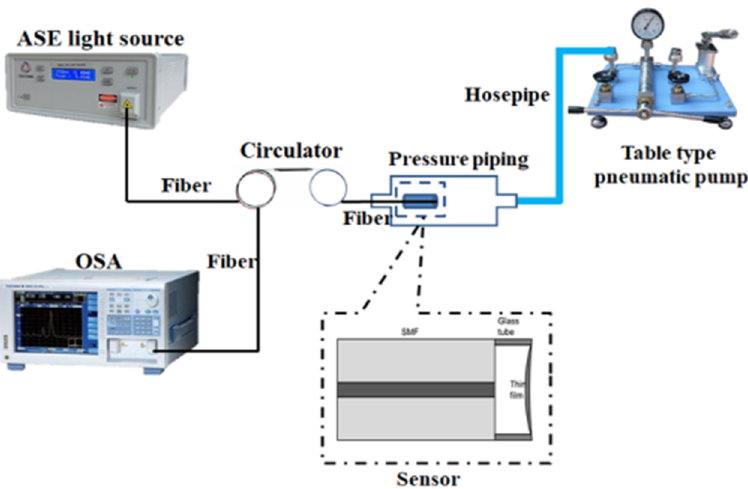
Figure 8. Schematic diagram of experimental test.